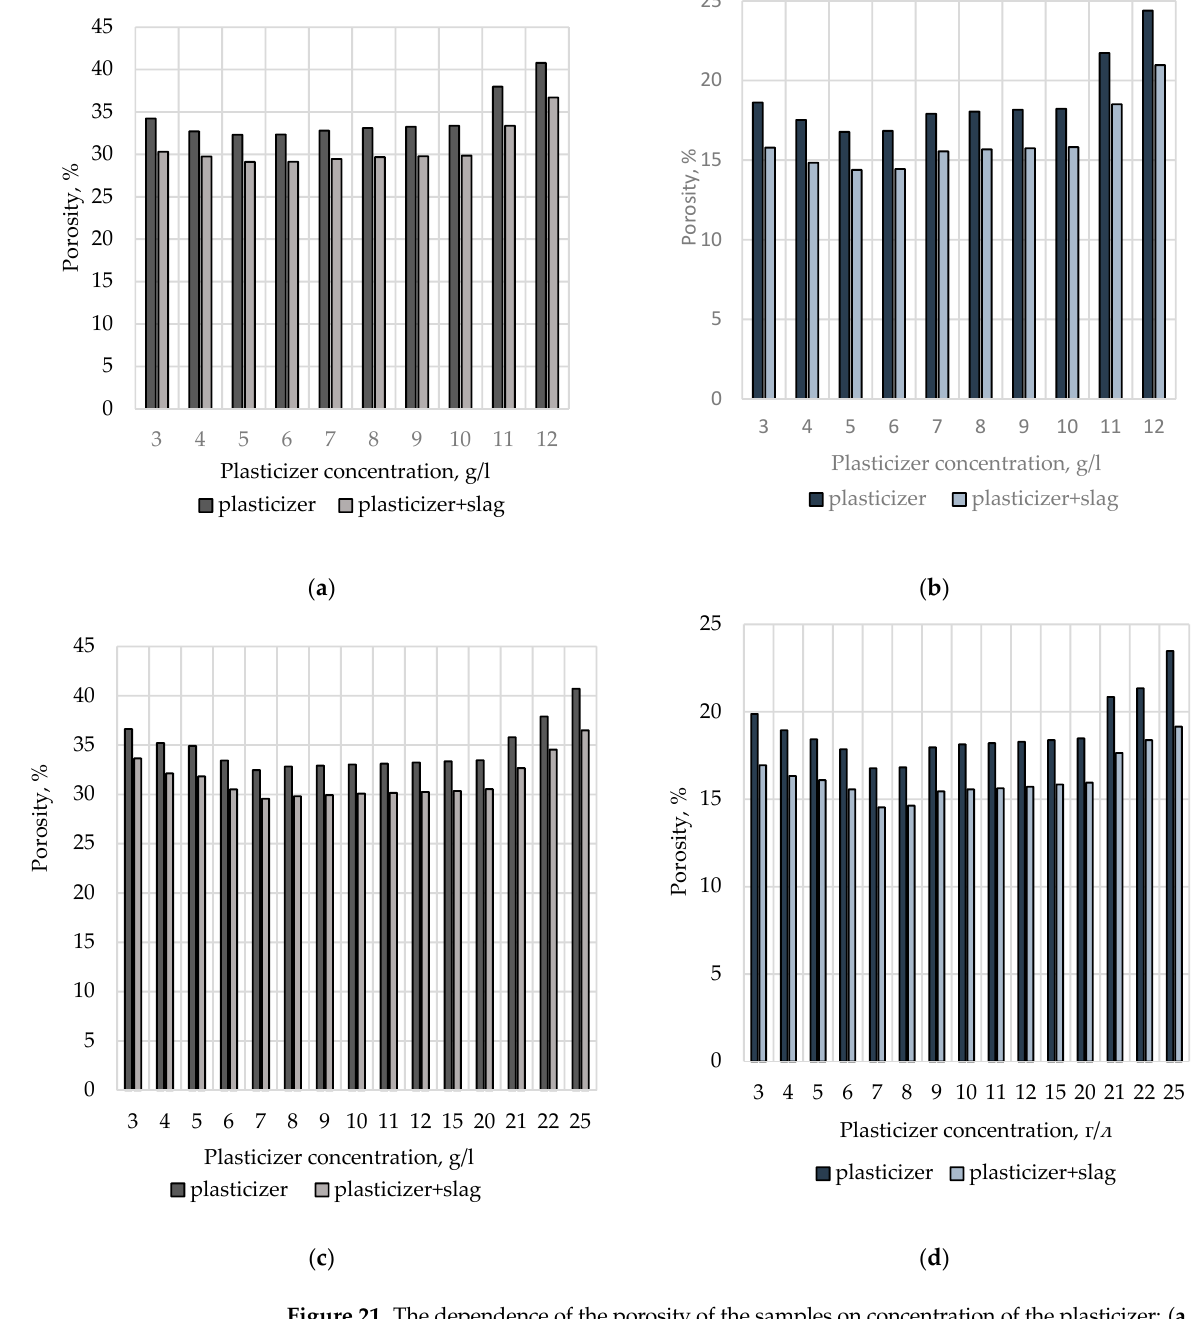
Figure 21. The dependence of the porosity of the samples on concentration of the plasticizer: ( a , b )—soft water (No. 1); ( c , d )—hard water (No.2); ( a , c )—1 day of hardening; ( b , d )—28 days of hardening.